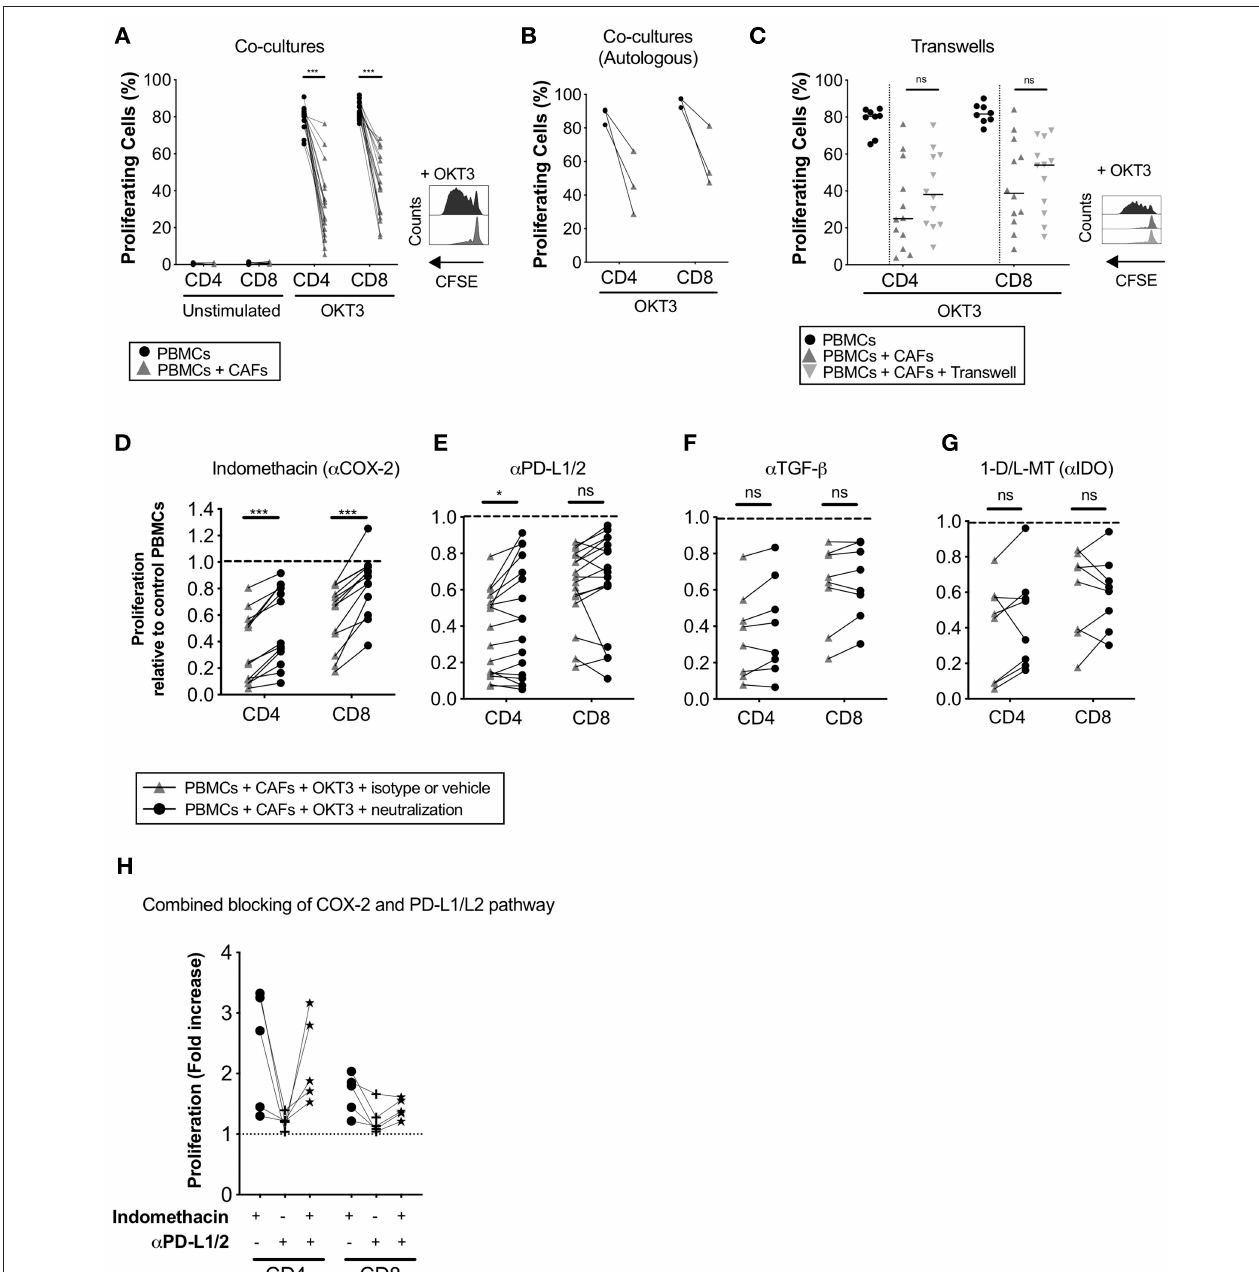
FIGURE 2 | CAFs inhibit T-cell proliferation, but COX-2 inhibition partially restores T-cells proliferation. CFSE-labeled PBMCs were co-cultured in the absence (•) or presence ( N ) of CAFs and stimulated with OKT3 (25ng/ml) for 5 days. (A) Frequency of proliferating CD4 + and CD8 + T-cells in the absence or presence of allogeneic CAFs in unstimulated ( n = 14) and stimulated ( n = 18) conditions (left). Representative CFSE histograms on CD4 + T-cells (right). (B) Frequency of proliferating patient-derived CD4 + and CD8 + T-cells in the absence or presence of autologous CAFs ( n = 3). (C) Frequency of proliferating CD4 + and CD8 + T-cells in direct co-cultures ( N ), indirect transwell cultures ( ) or without allogeneic CAFs (•) ( n = 12) (left). Representative CFSE histograms on CD4 + T-cells (right). (C–F) Proliferating CD4 + and CD8 + T-cells was measured by flow cytometry after addition of corresponding isotype control or vehicle ( N ) or the following blocking substances (•); (C) indomethacin to inhibit PGE 2 production ( n = 13), (D) anti-PD-L1 and anti-PD-L2 antibodies ( n = 17), (E) anti-TGF- β antibodies ( n = 8), or (F) 1-methyl-DL-tryptophan (1-D/L-MT) to inhibit indoleamine 2,3-dioxygenase (IDO) activity ( n = 8). (H) COX2 inhibition, PD-L1 and PD-L2 blockade or combined of both pathways ( n = 5). (A,C) The bars indicate the median. (B,D–H) Lines between dots indicate paired samples. Data are related to those of the control cultures without CAFs. Wilcoxon matched-pairs signed rank test was used to detect statistically significant differences between paired samples in the absence or presence of CAFs, and between cultures with isotype or vehicles and cultures with the different immunomodulatory factors neutralized, * P < 0.05, *** P < 0.001, ns, not significant.